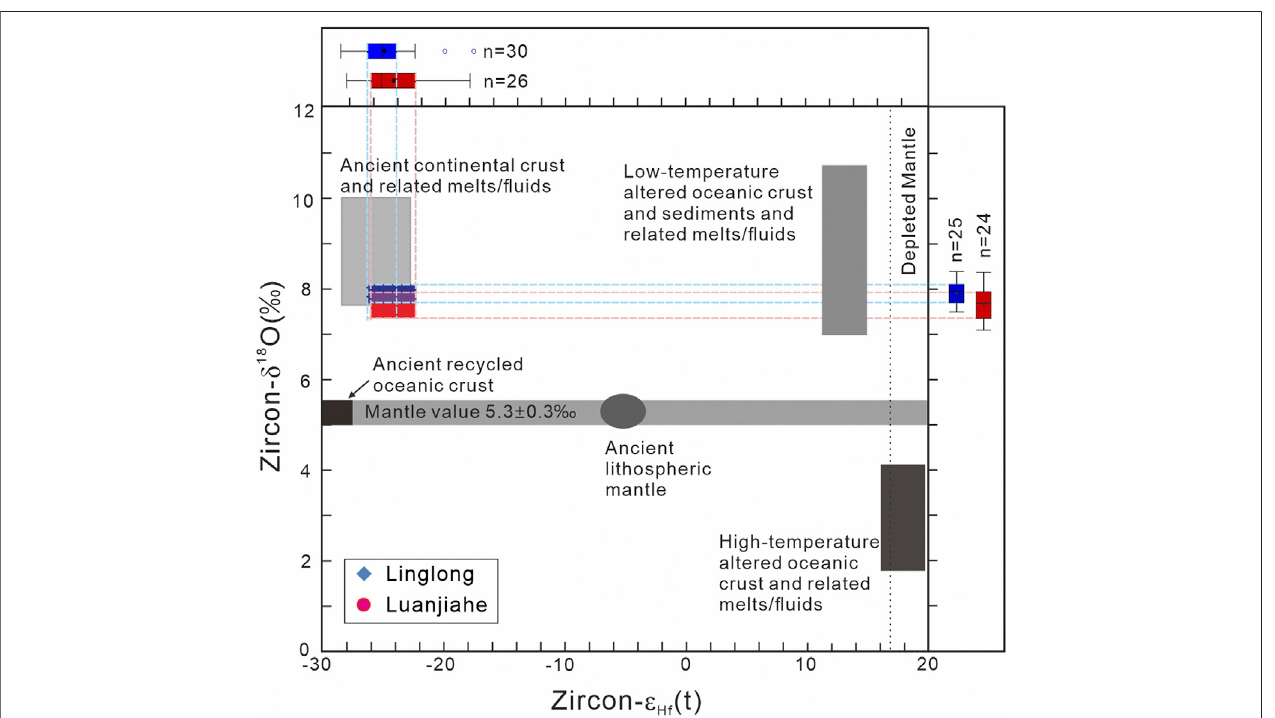
FIGURE 9 | Zircon ε Hf (t) vs δ 18 O diagram and related box diagrams for the Linglong and Luanjiahe granites. The Hf isotope data are from Yang et al. (2012). Areas of low-temperature altered oceanic crust and sediments and related melts/ fl uids, high-temperature altered oceanic crust and related melts/ fl uids, areas of the ancient lithospheric mantle, ancient continental crust, and ancient recycled oceanic crust are referred from Zhu et al. (2017).